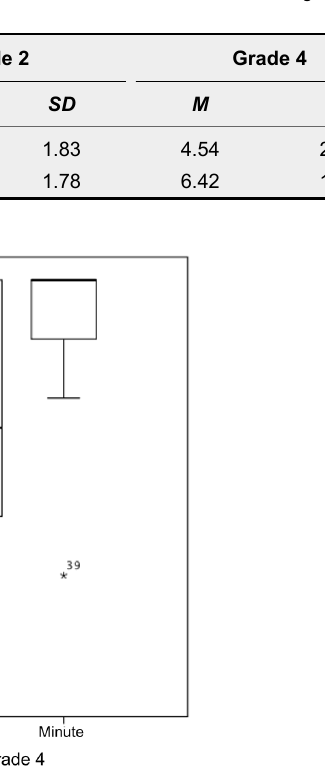
Figure 2. Boxplots showing performance on the seven Hand Positioning tasks for both hour and minute hands for each